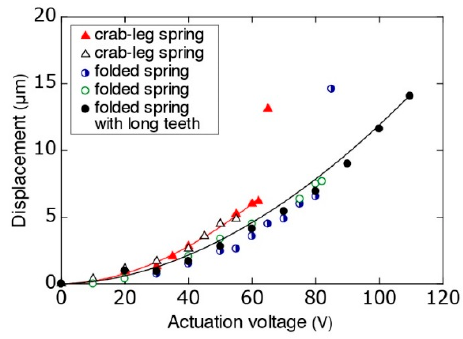
Figure 3. Actuation characteristics of various spring designs.